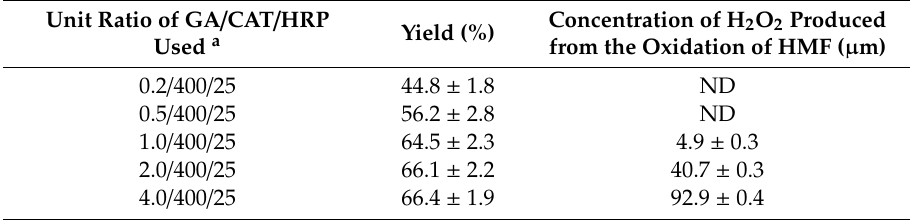
Table 1. The optimization of the proportion of enzymes added to the co-immobilization system. Unit Ratio of GA/CAT/HRP Concentration of H 2 O 2 Produced from the Yield (%) Used a